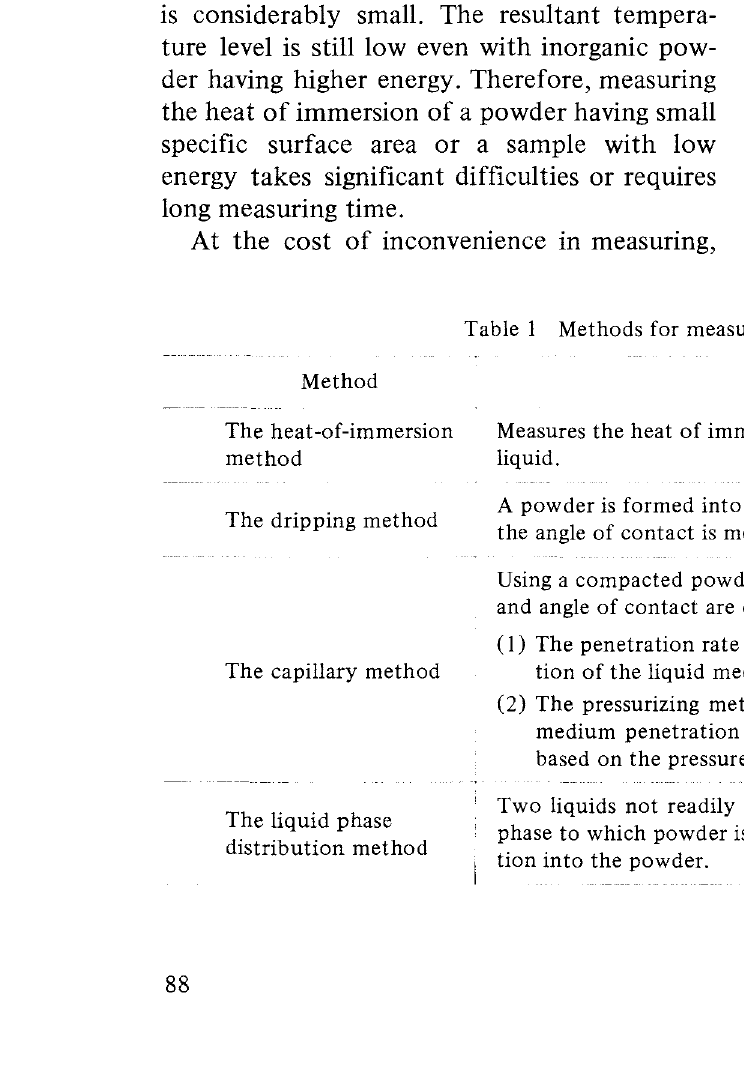
Table 1 Methods for measuring the wetting of